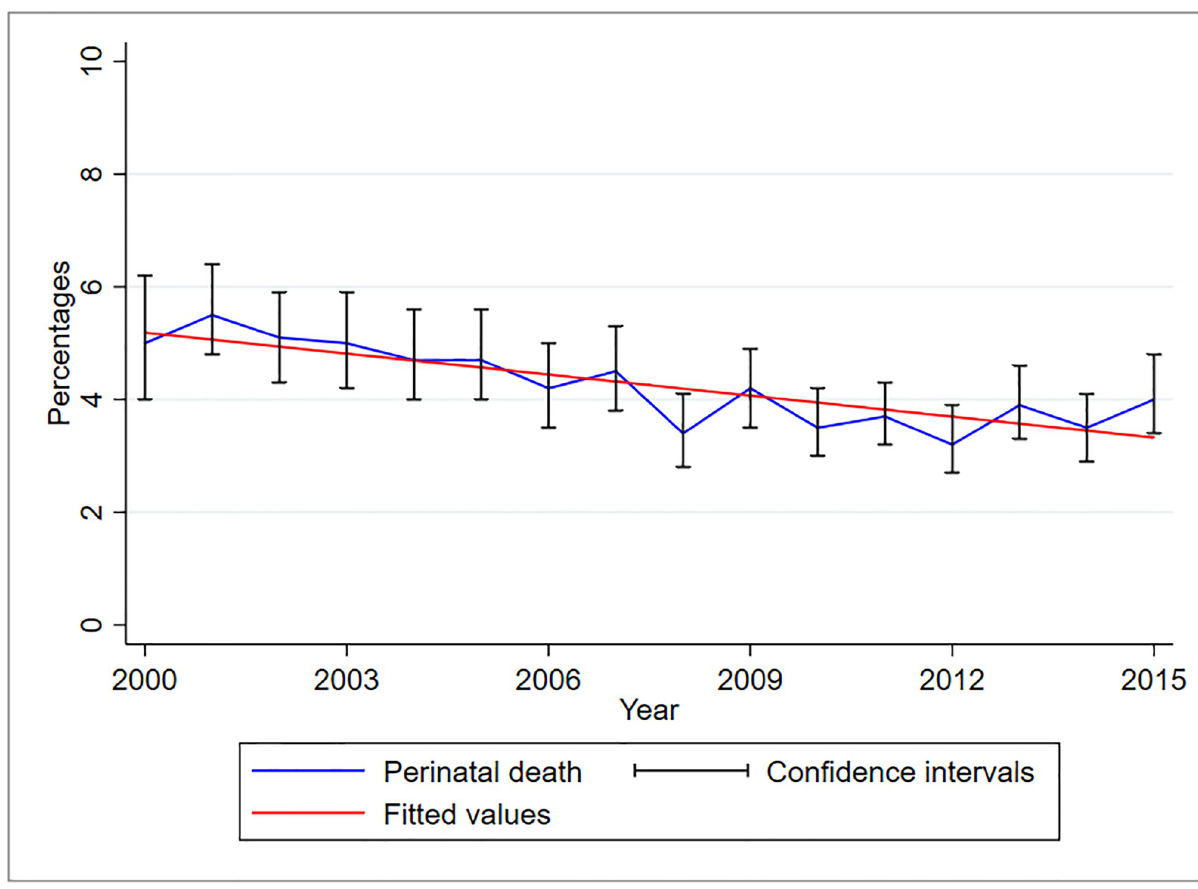
Fig 2. Trends of perinatal deaths, KCMC medical birth registry data, 2000–2015 (N = 50,724).